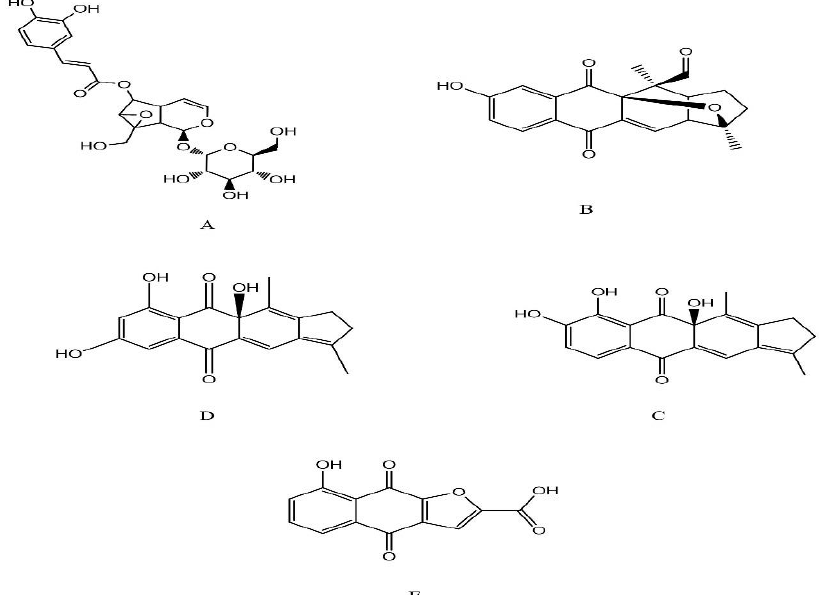
Figure 8. Structure of the phytochemicals identified by LC-MSMS in crude methanolic extracts of mature fruits (K m ) of K. pinnata in positive ion mode (TIC 1): ( A ) verminoside, ( B ) pinnatal, ( C ) kigelinol, ( D ) isokigelinol, ( E ) kigelinone.